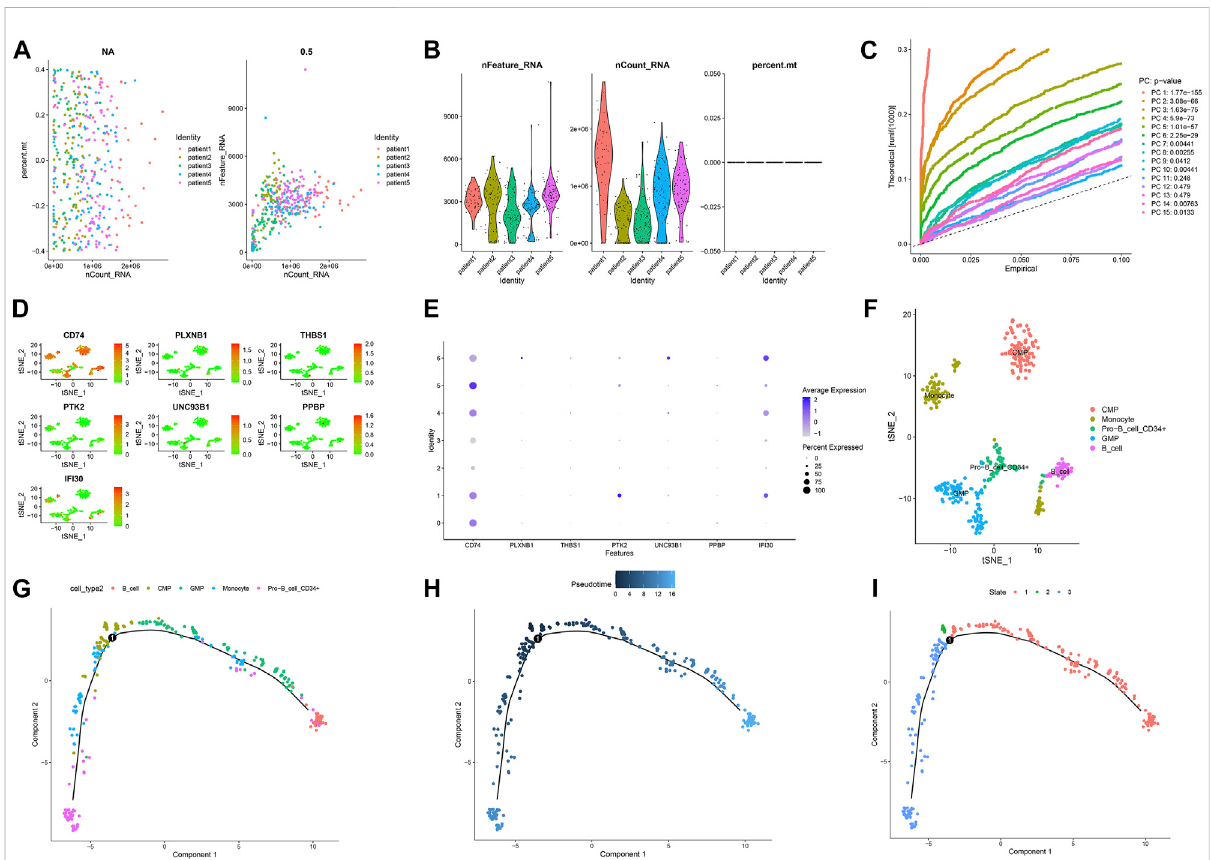
FIGURE 7 Single-cell sequencing results and pseudotime differentiation in AML patients at diagnosis. (A) RNA count charts of 5 patients. (B) Sequencing depth, gene count, and mitochondrial content of 5 patients. (C) PCA dimension reduction was performed on characteristic genes. (D – E) Expression of 7 prognostic genes in cell subsets. (F) Annotation results of cell subsets. (G) Sequence of different cell clusters along pseudo-time. Infer cell sequence from expression of the most dispersed genes in the cell cluster. Each point corresponds to a cell, and each color represents a state. (H) The darker the blue, the earlier the differentiation, and the lighter the blue, the later the differentiation. (I) Each color represents a different